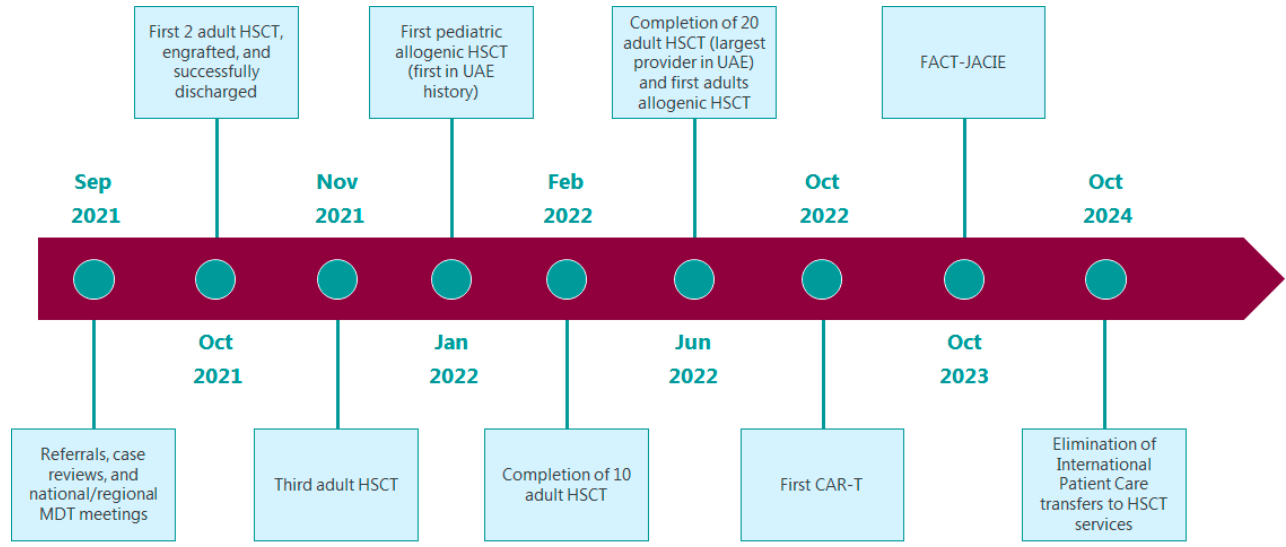
Figure 2. Hematopoietic stem cell transplant unit future plans. HSCT, hematopoietic stemcell transplantation; CAR-T, Chimeric antigen receptor T; FACT-JACIE, Foundation for the Accreditation of Cellular Therapy–Joint Accreditation Committee.